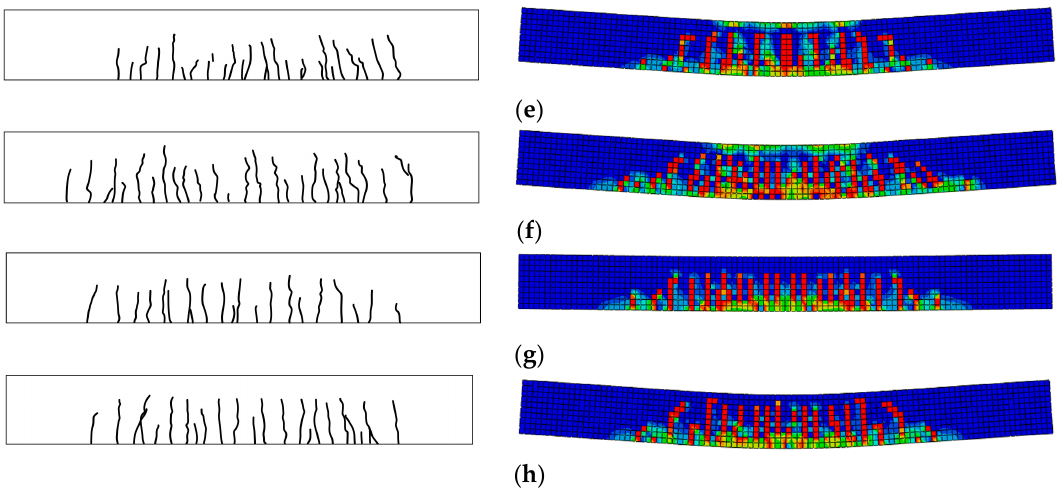
Figure 7. Crack development of test and FE results. ( a ) C30R50F1, ( b ) C45R0F1, ( c ) C45R50F1, ( d ) C45R50F0, ( e ) C45R50F2, ( f ) C45R30F1, ( g ) C45R100F1, ( h ) C60R50F1.